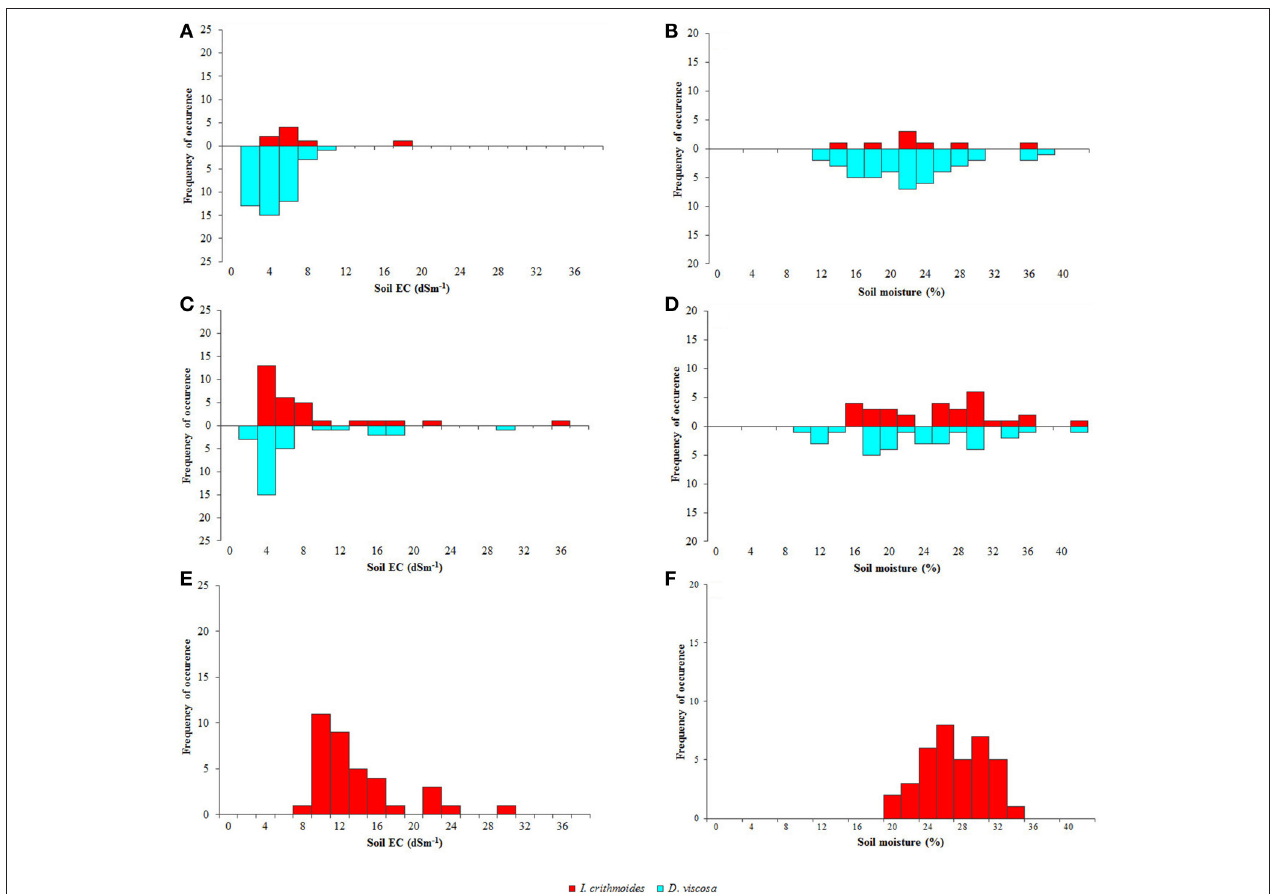
FIGURE 2 | Abundance and distribution of Dittrichia viscosa (light blue bars) and Inula crithmoides (red bars) plants in salt marshes 1 (A,B), 2 (C,D), and 3 (E,F), according to soil electric conductivity (EC, dS m − 1 ) (A,C,E) and soil moisture (%) (B,D,F).